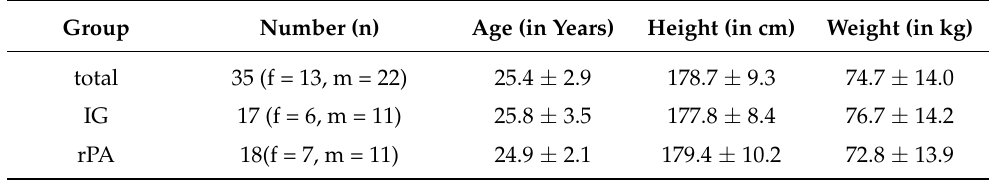
Table 1. Characteristics of test subjects. Group Number